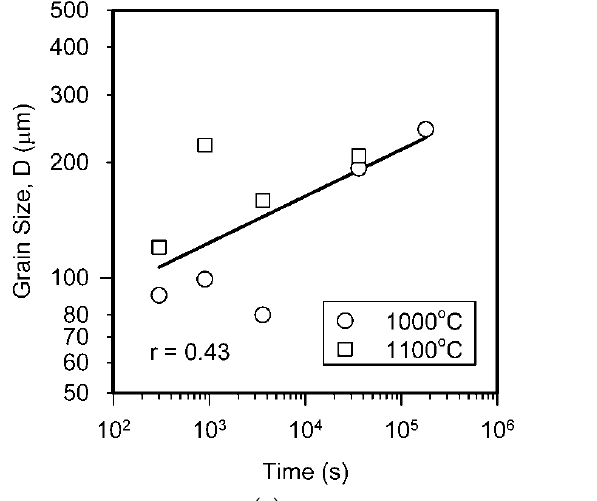
Figure 4. Grain boundary network in the steel samples annealed at 1000 °C for 5 min ( a ), at 1000 °C for 50 h ( b ), at 1100 °C for 5 min ( c ), and at 1100 °C for 10 h ( d ). Black and red lines indicate ordinary and ∑ 3 n CSL boundaries, respectively.